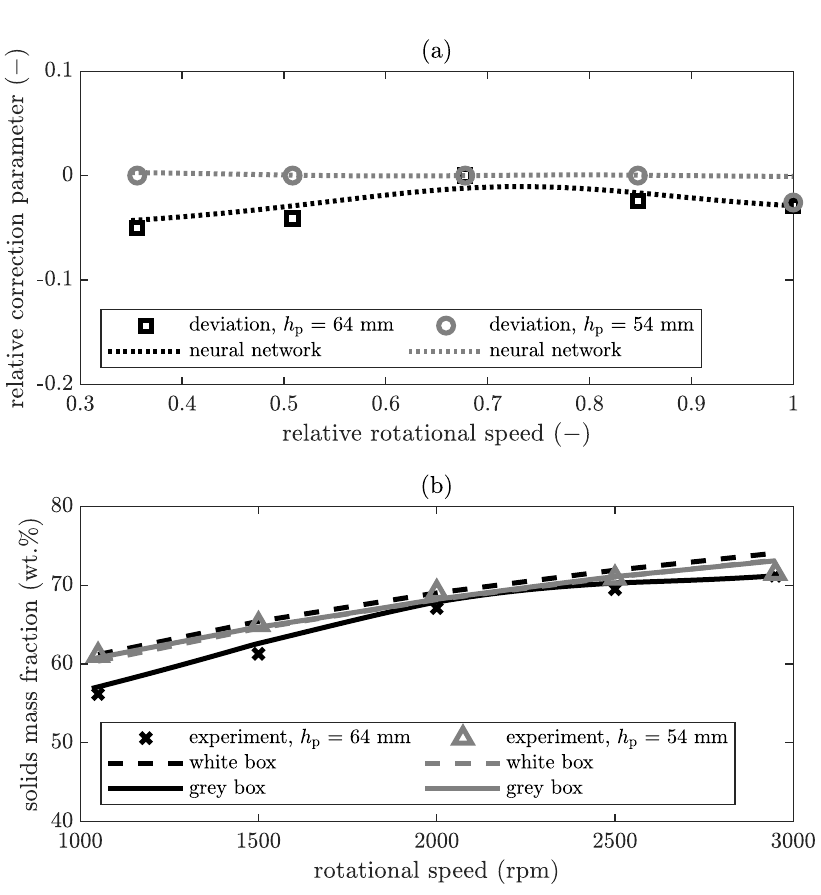
Figure 7. Solids mass fraction of the cake at a constant volumetric flow rate of ˙ V in = 2000Lh − 1 for the product CC1: ( a ) relativised output of the black box model, ( b ) comparison of the results from experiment, white, and grey box